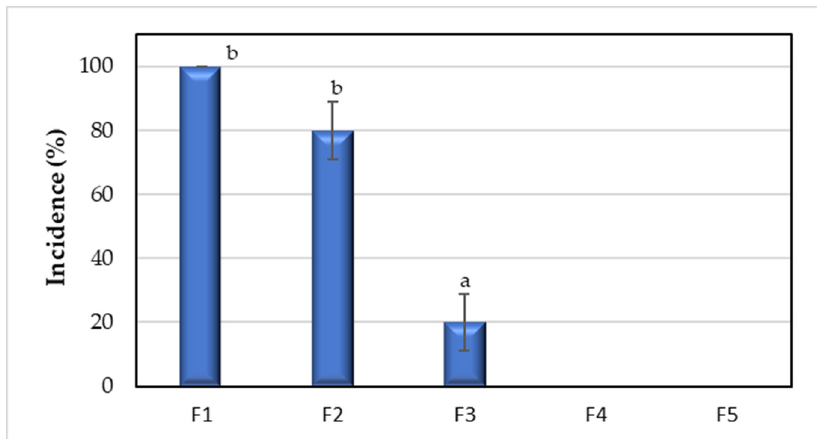
Figure 5. Disease damage incidence S. lycopersicum with CS + RGEO coatings stored for 12 days at 4.0 ± 2 °C. F1 = Control; F2 = CS; F3 = CS + RGEO 0.5%; F4 = CS + RGEO 1.0%; F5 = CS + RGEO 1.5%. Mean values and intervals of LSD 95% according to the ANOVA test. The superscript letter (a–b) refers to the significant differences ( p < 0.05) between each treatment.